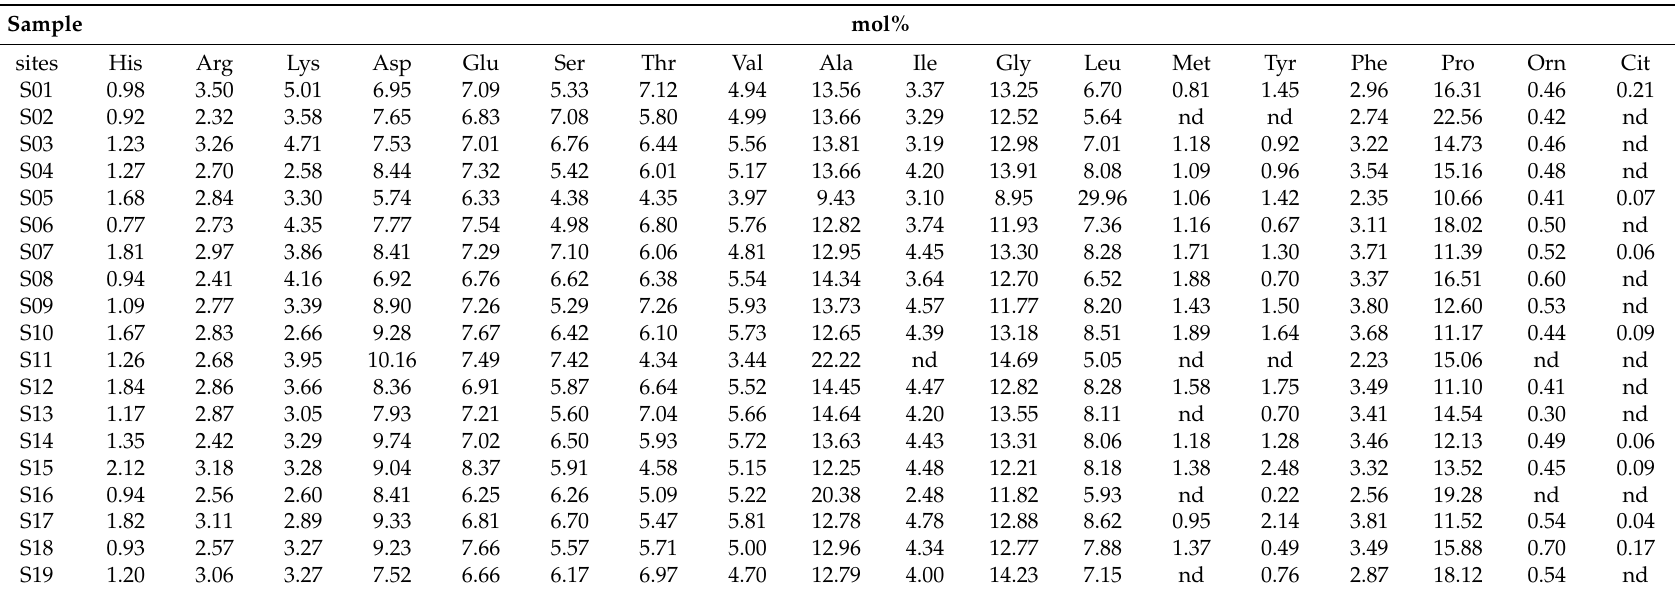
Table 1. Mole percent composition of amino acids in surface sediments of the Ziya River